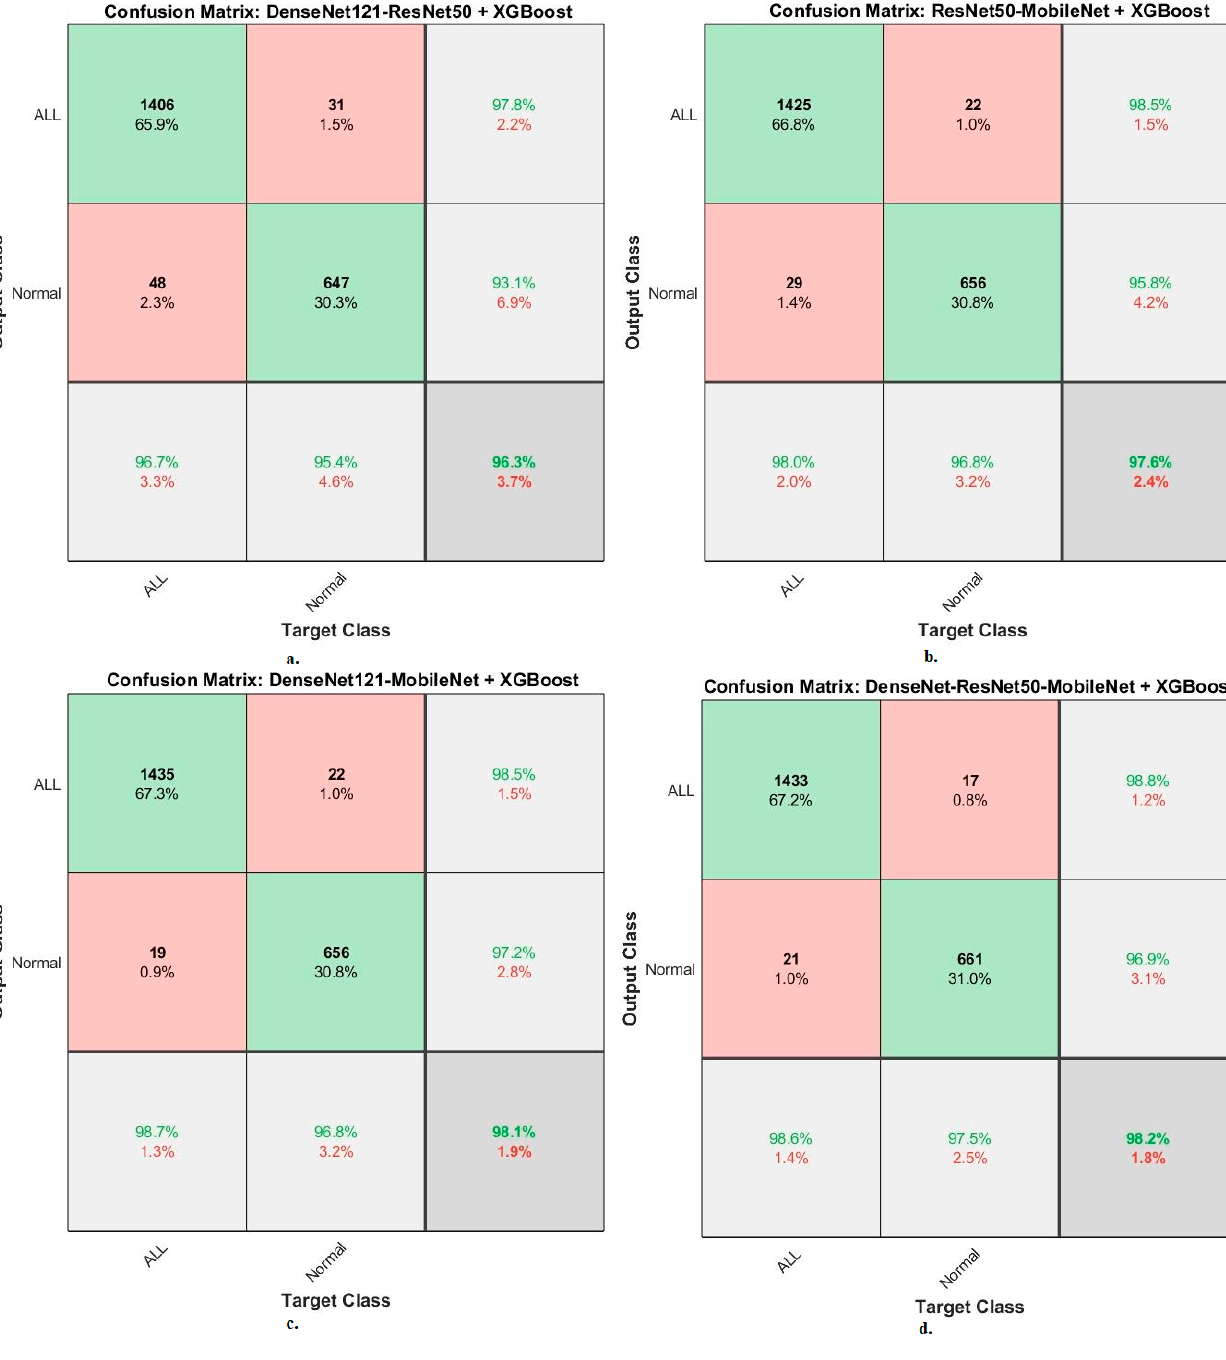
Figure 16. Results of the XGBoost classifier based on fusion features of the CNN models of the C- NMC 2019 dataset for the diagnosis of acute leukemia, confusion matrix of ( a ) DenseNet121-ResNet50, ( b ) ResNet50-MobileNet, ( c ) DenseNet121-MobileNet, and ( d ) DenseNet121-ResNet50-Mo- bileNet.